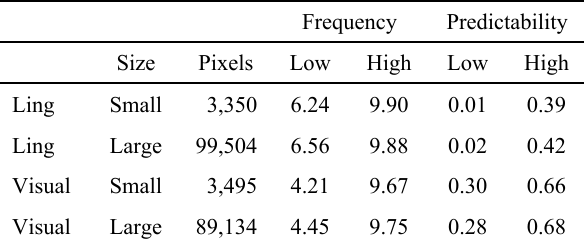
The average area, frequency, and predictability of objects Frequency